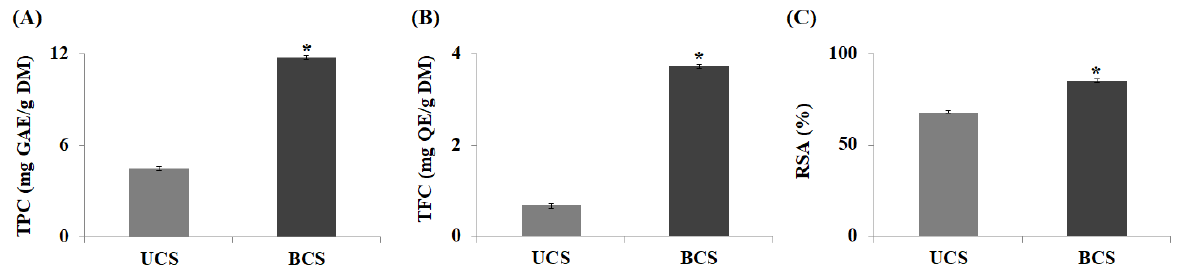
Figure 1. Comparisons of TPC ( A ), TFC ( B ), and RSA ( C ) changes in UCS and BCS by bioconversion. UCS: ultrasound-assisted extracts of chestnut inner shell; BCS: bioconverted chestnut inner shell extracts; TPC: total polyphenol content; TFC: total flavonoid content; RSA: radical scavenging